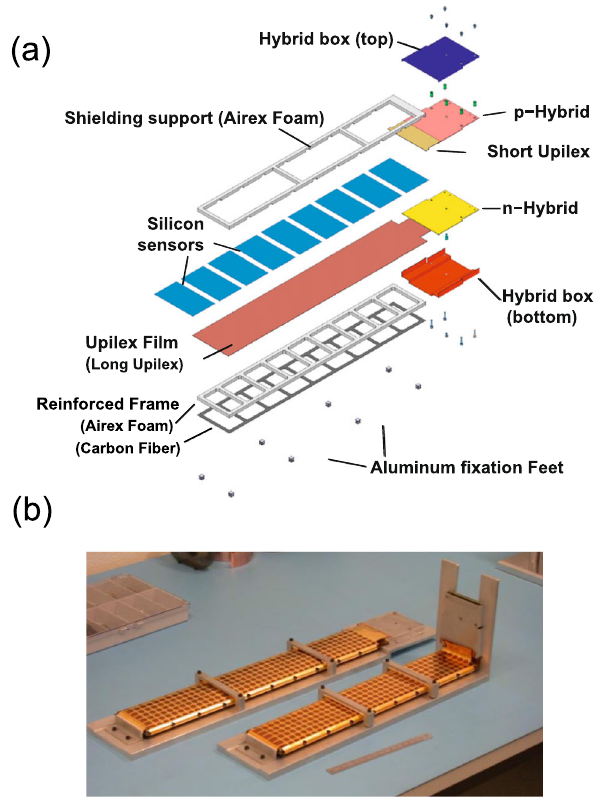
Fig. 2 The AMS silicon tracker ladder: a the main components of the ladder and b two assembled ladders